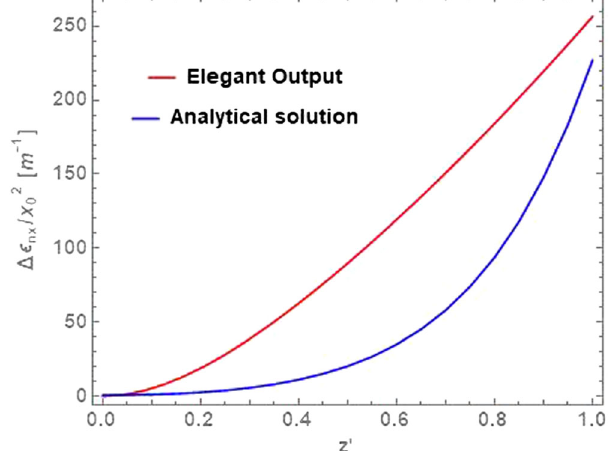
FIG. 47. Comparison of the normalized emittance growth where ϵ ð z 0 Þ given by Eq. (62) between the ELEGANT tracking code results and the analytical formulation for a bunch which has traveled through the 24 rf structures of XARA. Shown in red is the normalized emittance calculated via ELEGANT . The analytical result is shown in